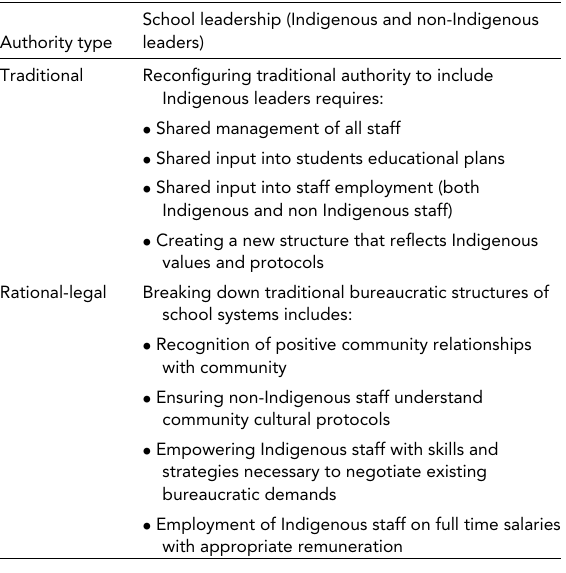
Dimensions That Assist the Transition Within the School Context Authority type